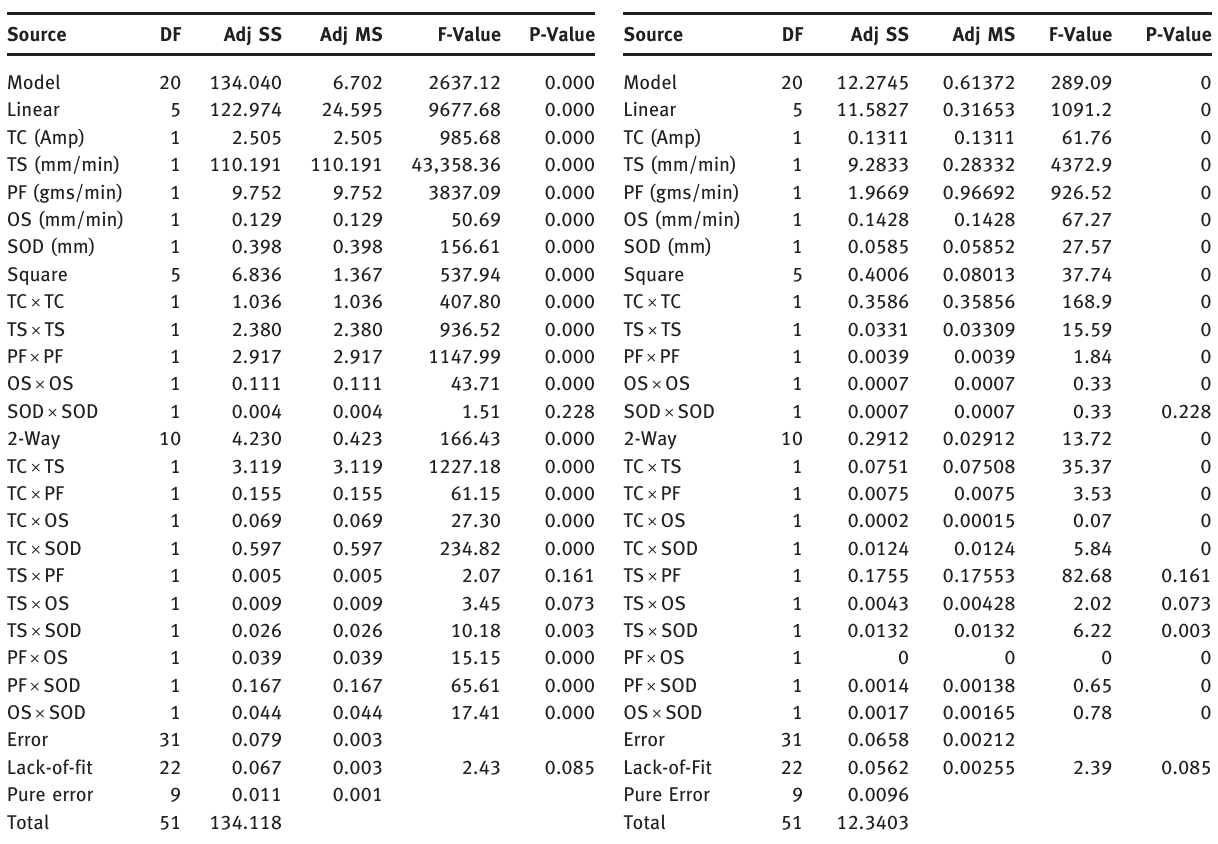
Table 5: Analysis of variance for